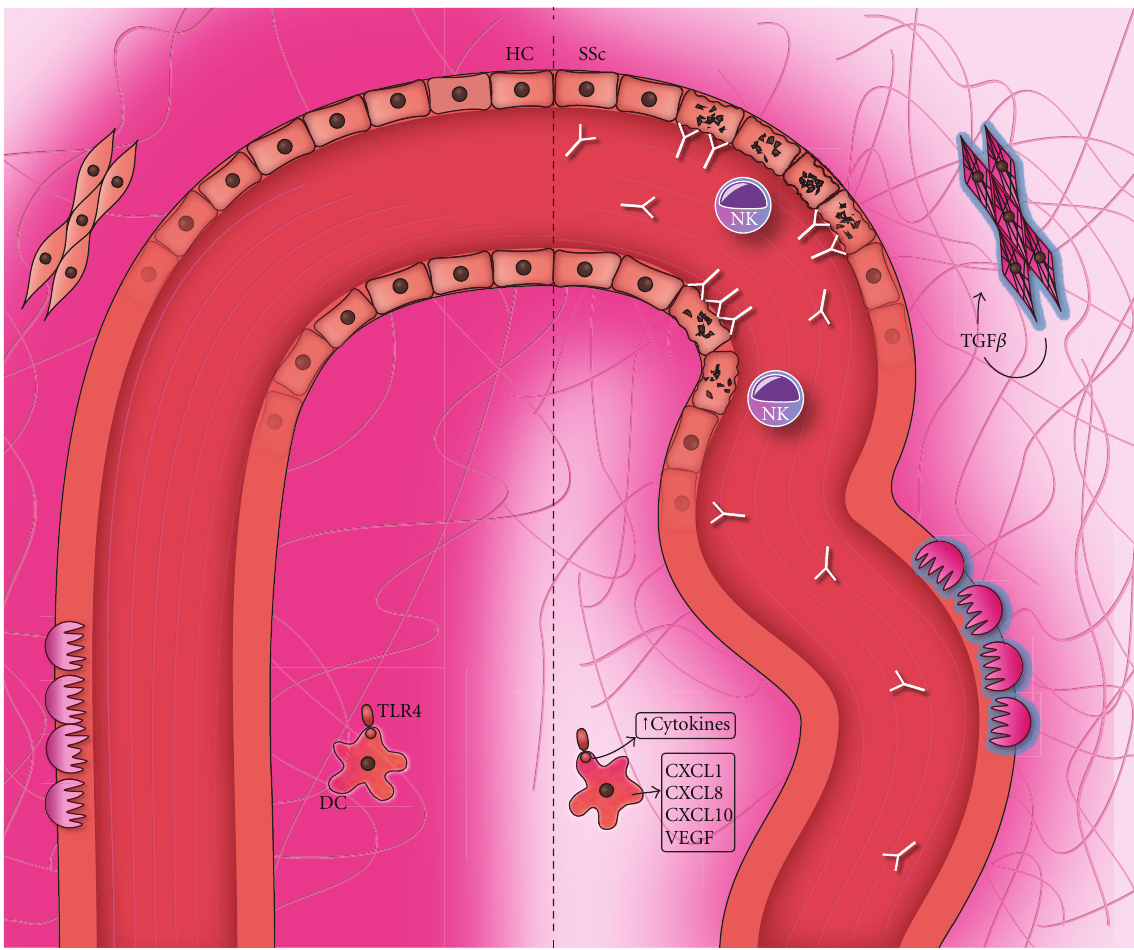
Figure 1: Hypoxia in the pathogenesis of systemic sclerosis. The left side illustrates the normal situation, with a healthy blood vessel delivering oxygen to the surrounding tissue. The right side represents the situation in SSc, where the diseased vessel and overwhelming deposition of collagen fibers prevent the oxygen from reaching the periphery. In the vessel, endothelial apoptosis as a result of antibody- dependent cytotoxicity is visible. Surrounding the ECs, activated pericytes are responsible for the deposition of collagen. The resulting hypoxia leads to a higher cyto- and chemokine production by DCs, in part triggered by TLR stimulation, and to a continuing loop of TGF β production, collagen synthesis, and myofibroblast di ff erentiation of fibroblasts. This in turn leads to a hindered dispersion of oxygen, keeping the vicious circle going